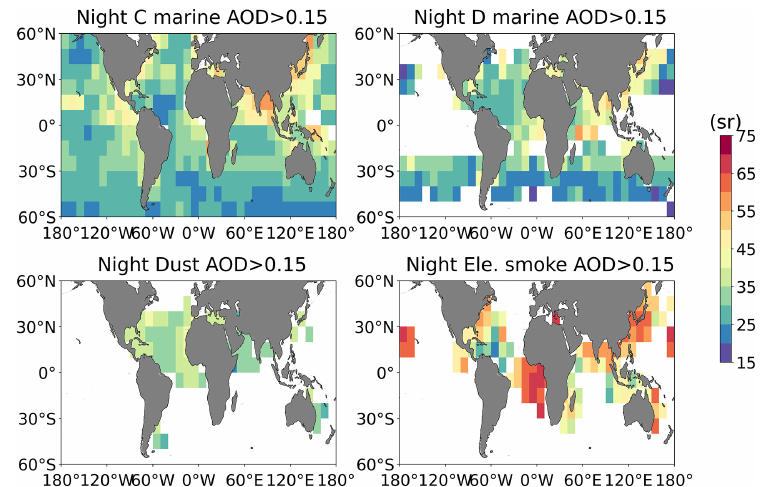
Figure A4. Same as Fig. A3 but for